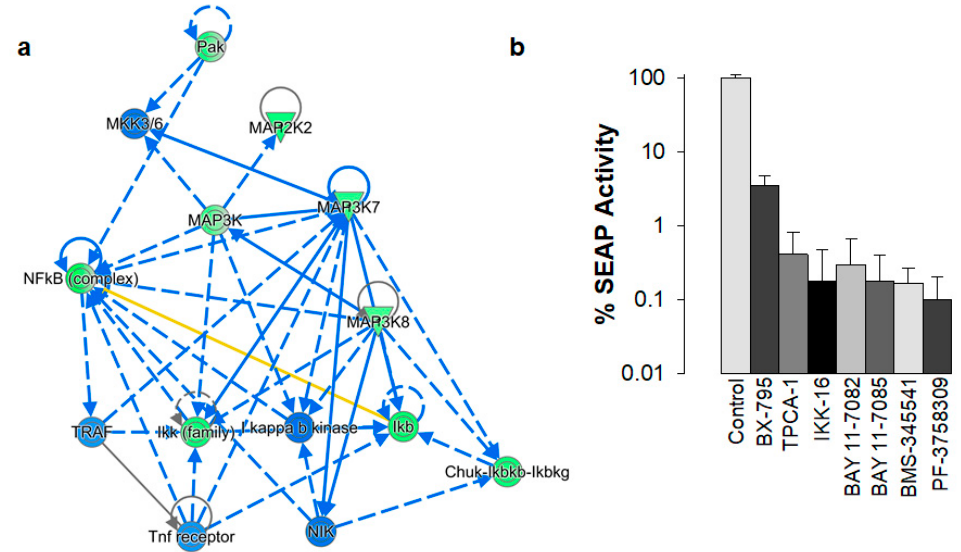
Figure 5. PF-3758309 and NF- κ B signaling in 24ST1NLESG cells. ( a ) Qiagen Ingenuity Pathway Analysis was used to generate the functional network of the Phospho Antibody Array. The NF- κ B signaling pathway was found to be significantly down-regulated ( p -value 2.83 × 10 − 24 ). Lines and arrows between nodes represent direct (solid lines) and indirect (dashed lines) interactions between molecules as supported by information in the Ingenuity knowledge base. Green nodes represent decreased measurement in the dataset. Blue color represents predicted inhibition. The yellow line indicates findings inconsistent with state of downstream molecule. The gray line indicates effect not predicted. The circular line arrow indicates that a molecule interacts with itself. ( b ) Characterization of NF- κ B inhibitors on HIV-1 latency mediated by TNF- α in the 24ST1NLESG cell line. Six different inhibitors (BX-795, TPCA-1, IKK-16, BAY11-7082, BAY11-7085, and BMS-345541) were used at a concentration of 2 µM. No cellular toxicity was observed. PF-3758309 was used as a concentration of 100 nM. Data are shown as mean ± standard deviation from at least three independent biological replicates.